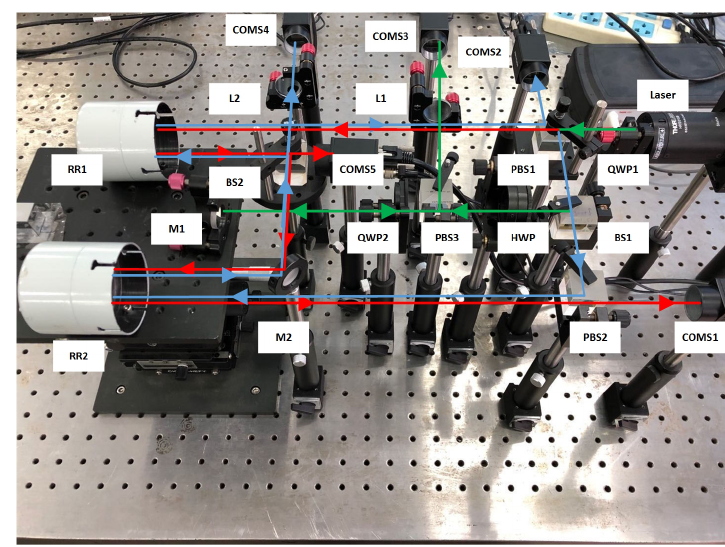
Figure 7. Experimental setup for the five-degree-of-freedom motion error measurement.